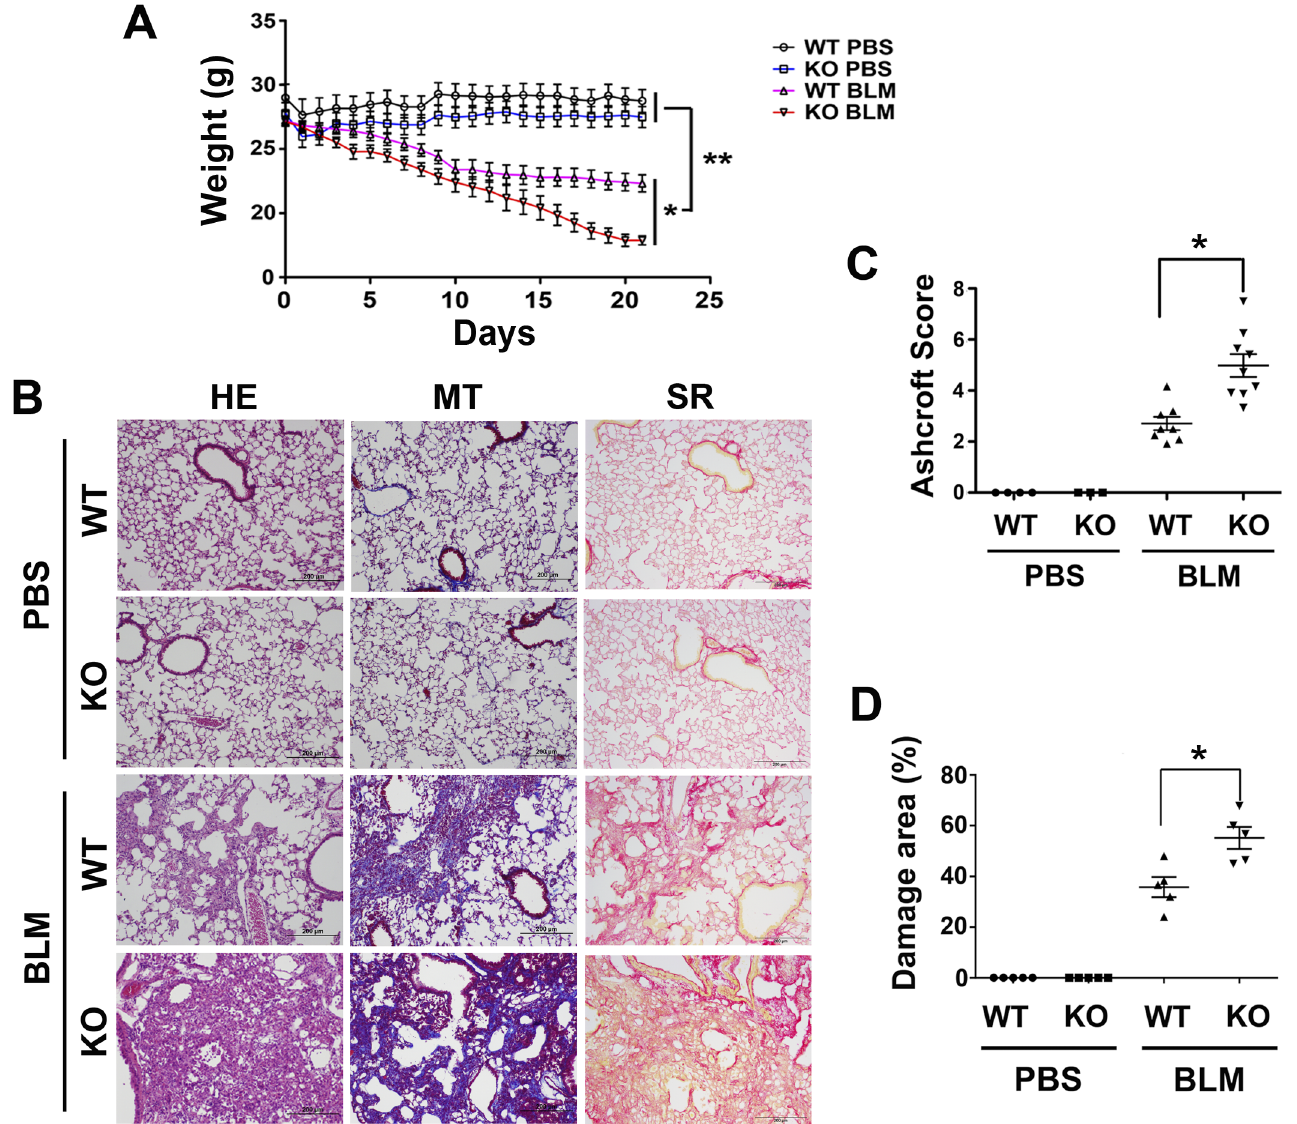
Fig 1. BLM-induced pulmonary fibrosis model. (A) Weight curves for wild-type (WT) and Scgb3a2 -null (KO) mice during the entire experimental period of 21 days. Mice were intratracheally intubated bleomycin on day 0, and subjected to necropsy on day 21. Their weights were monitored daily. The mean ± SD are shown. N > 10 in each group. * P < 0.05, ** P < 0.01 by student ’ s t -test. (B) H&E staining (HE), Masson Trichrome staining that detects collagen fibers (MT), and Sirius Red staining for fibrosis severity (SR) of wild-type (WT) and Scgb3a2 -null (KO) mice intubated with BLM or PBS as a control are shown. Representative images from N > 3 in each group. Severe fibrosis is present in BLM-administered Scgb3a2 -null lung. Scale bar: 200 μ m. (C) Ashcroft Scores indicating the degree of fibrosis. (D) Damaged area determined by Sirius Red staining. The mean ± SD from N > 3 in each group are shown. * P < 0.05 by one- way